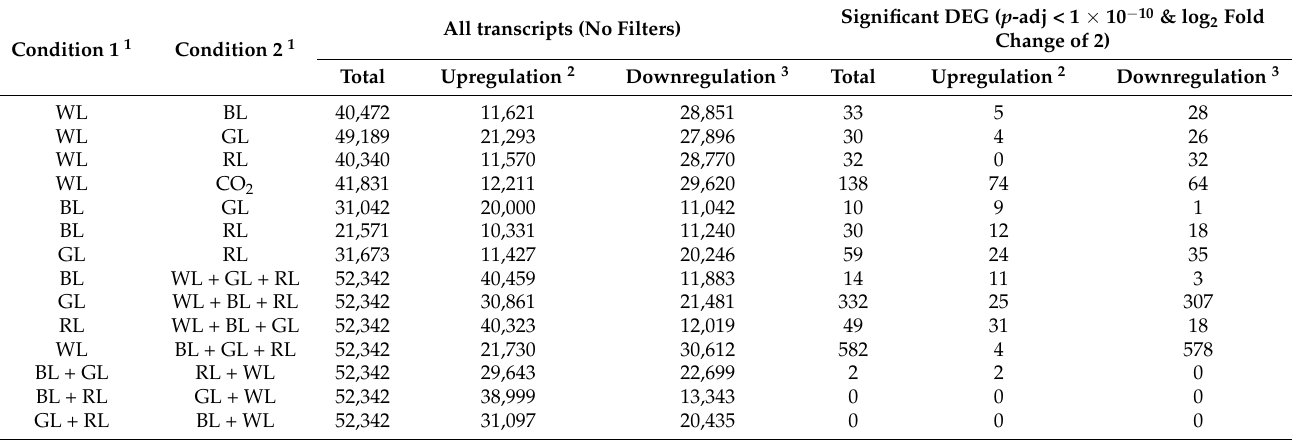
Figure 5. Total numbers of upregulated (red) and downregulated (blue) genes in Kappaphycus alvarezii between two treatments (with and without CO 2 treatment and between different light treatments) with an adjusted p -value < 1 × 10 − 10 and a log 2 fold change ≥ 2. BL, blue light; GL, green light; RL, red light. Table 4. Analysis of differential expression at transcript